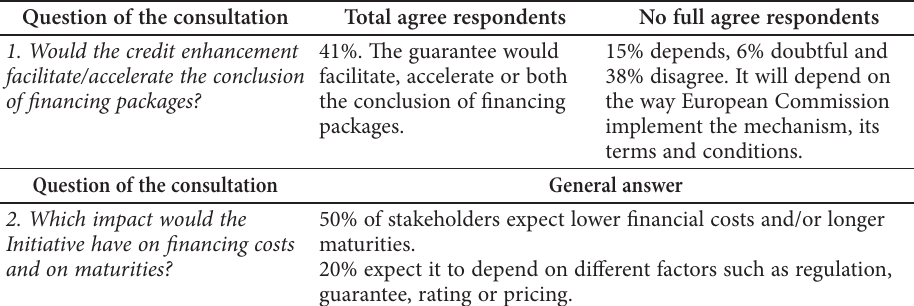
Table 3. Summary of the responses to the questions of the consultation regarding cost and efficiency of project